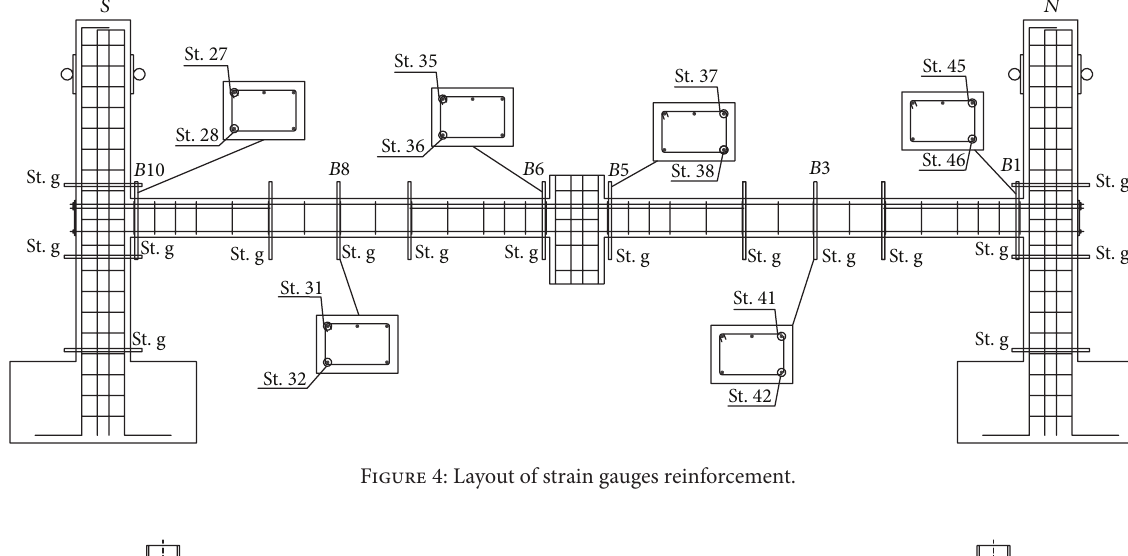
Figure 4: Layout of strain gauges reinforcement.